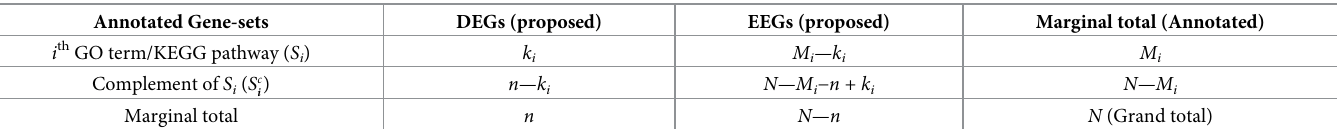
Table 1. Contingency